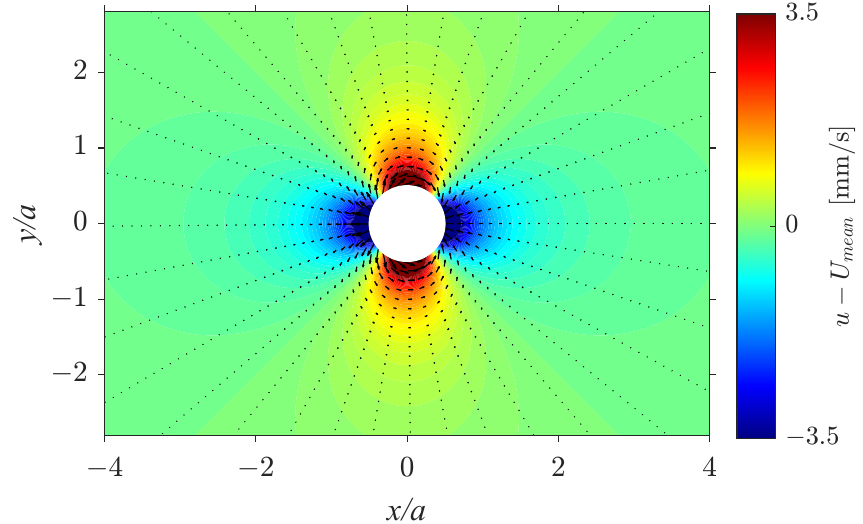
Figure 4. Analytical calculation of a two-dimensional potential flow passing a circular obstacle with the longitudinal velocity u − U mean in color and the vector field U − U mean shown with black